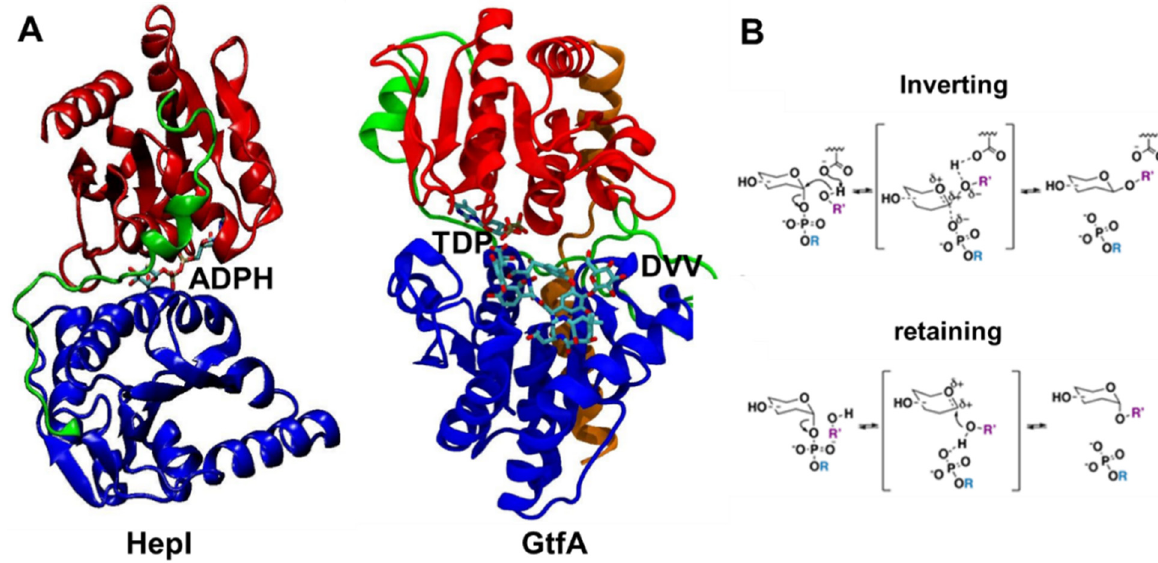
Figure 1. Crystal structures of ligand-bound glycosyltransferases: ( A ) HepI (PDB: 2H1H) and GtfA (PDB: 1PN3) colored for N domain (blue), C domain (red), linker (green), and spine (orange, only in GtfA) regions. HepI and GtfA cofactors, ADPH and TDP, respectively, and GtfA substrate DVV, are shown as ball and stick representation, which are located between N and C domains. Ligands are included to highlight the location of the binding catalytic site. ( B ) Inverting and retaining mechanisms by glycosyltransferases. Our simulations were performed without any substrates for the unbound HepI and GtfA.